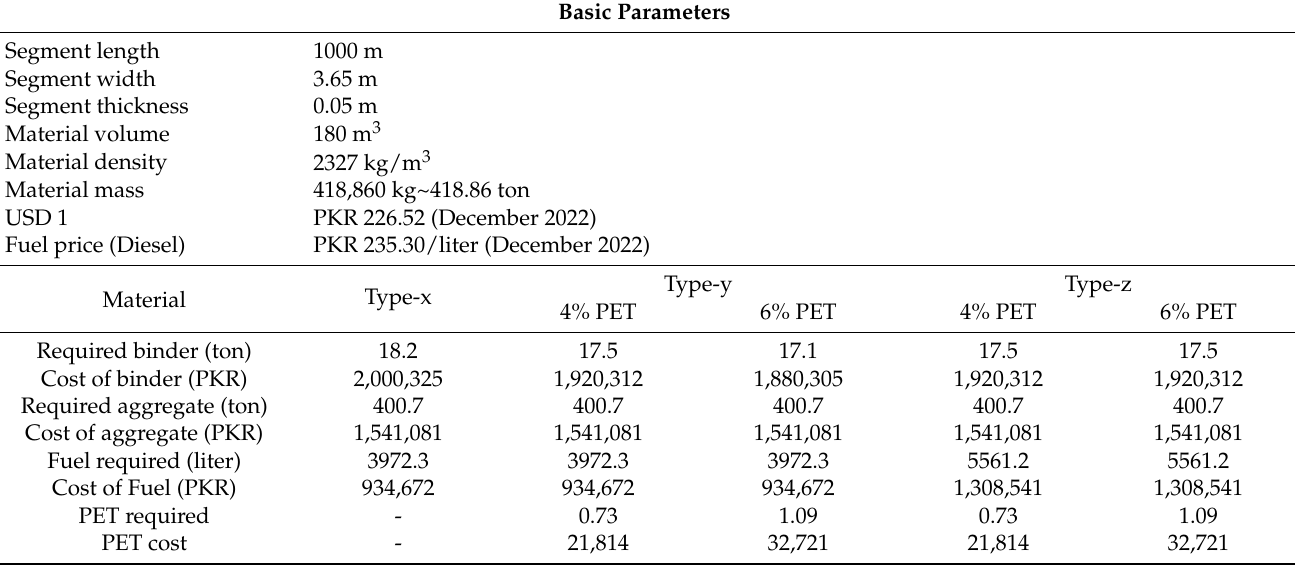
Table 8. Cost analysis